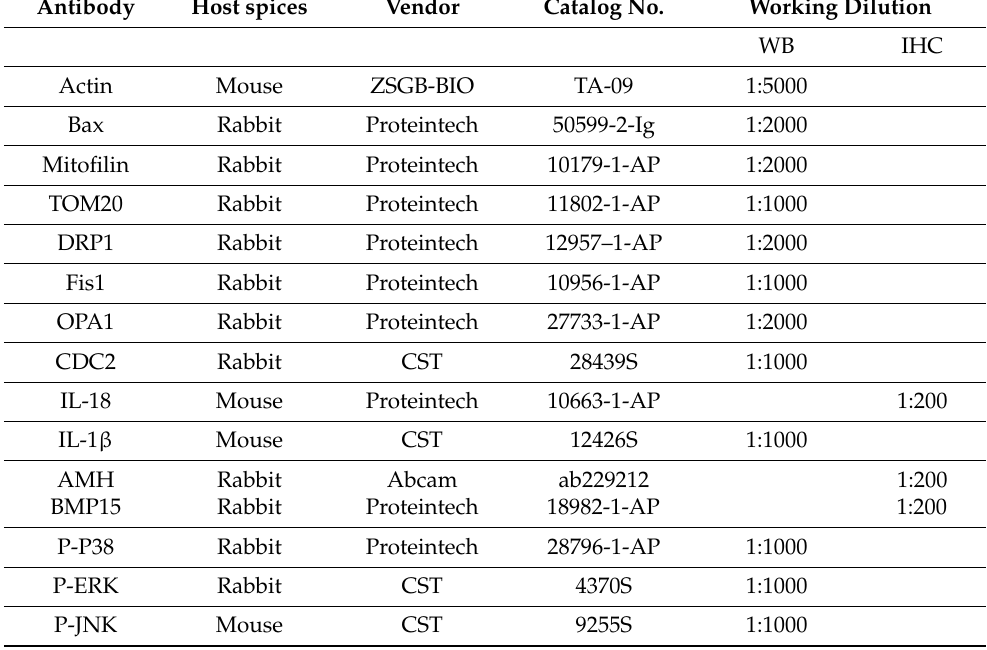
Table 1. Detailed information on